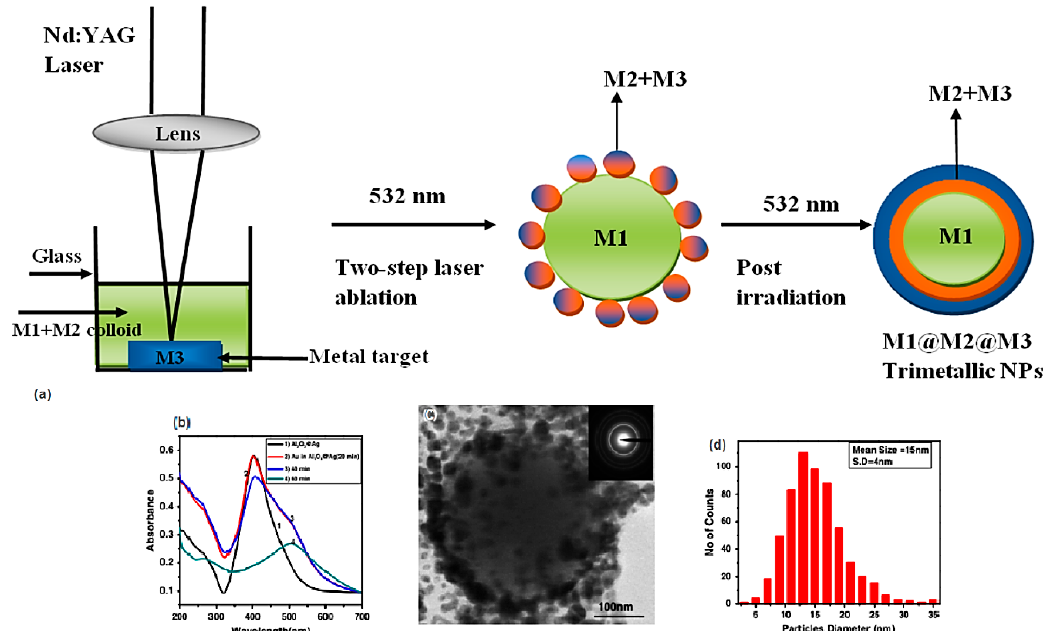
Figure 5. ( a ) The fabrication process of trimetallic nanoarchitectures by applying multiple-step laser ablation technique. ( b ) UV–VIS spectra, ( c ) TEM image, and ( d ) size distribution of Al 2 O 3 @AgAu NPs in deionized water. Reproduced from [100], with permission from Springer Nature, 2014.